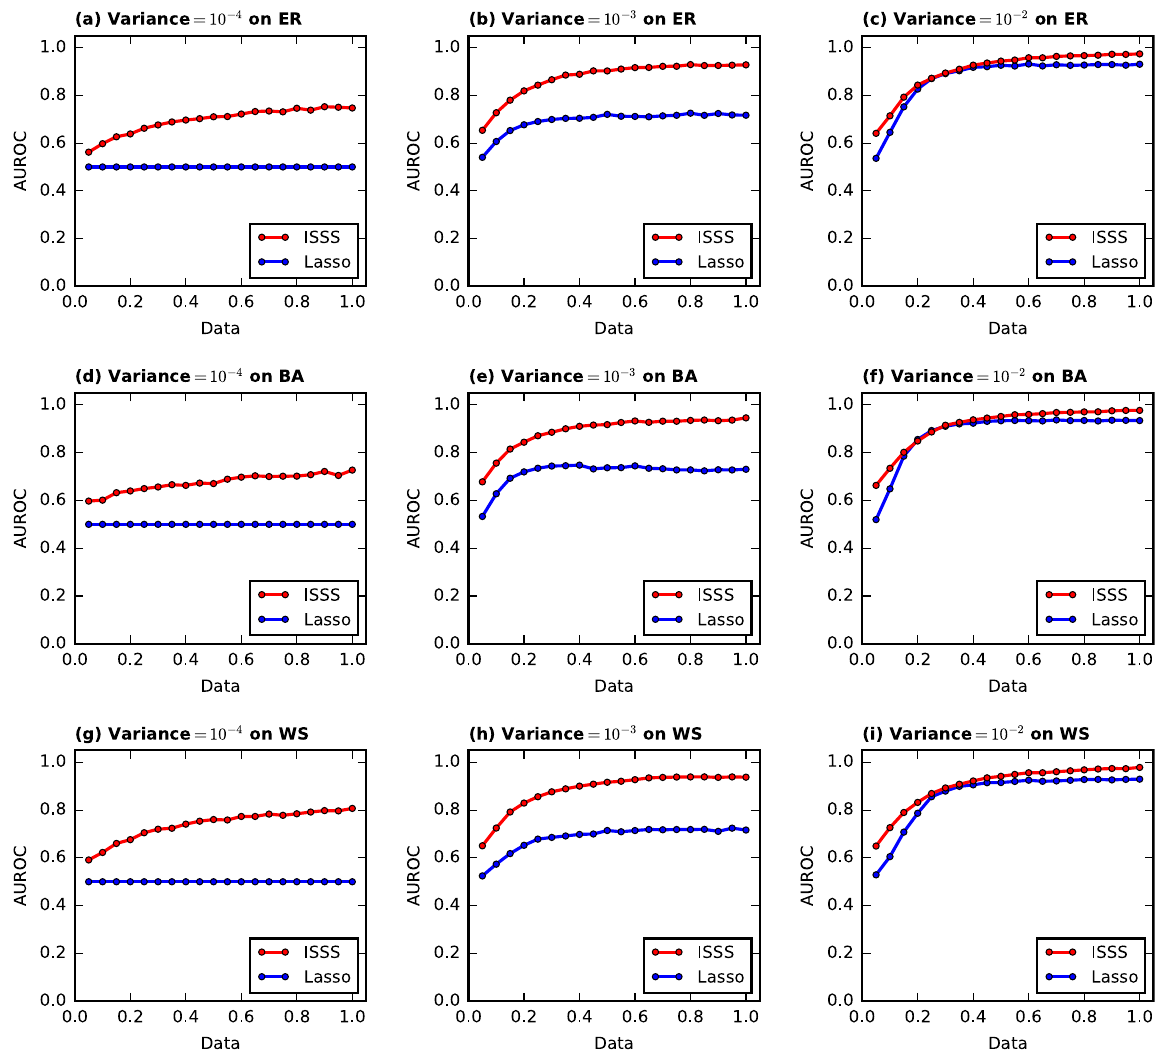
Figure 2. The performance of ISSS and Lasso on the data with variance = 10 − 2 , 10 − 3 and 10 − 4 . With very small variance = 10 − 4 , the performance of Lasso is equal to random guess, i.e., the blue line in Fig. 2(a,d,g). With very large variance, the inference or reconstruction task is much easier. To show the whole curves, the upper bound of the y axis is set to 1.2 for all the figures in this